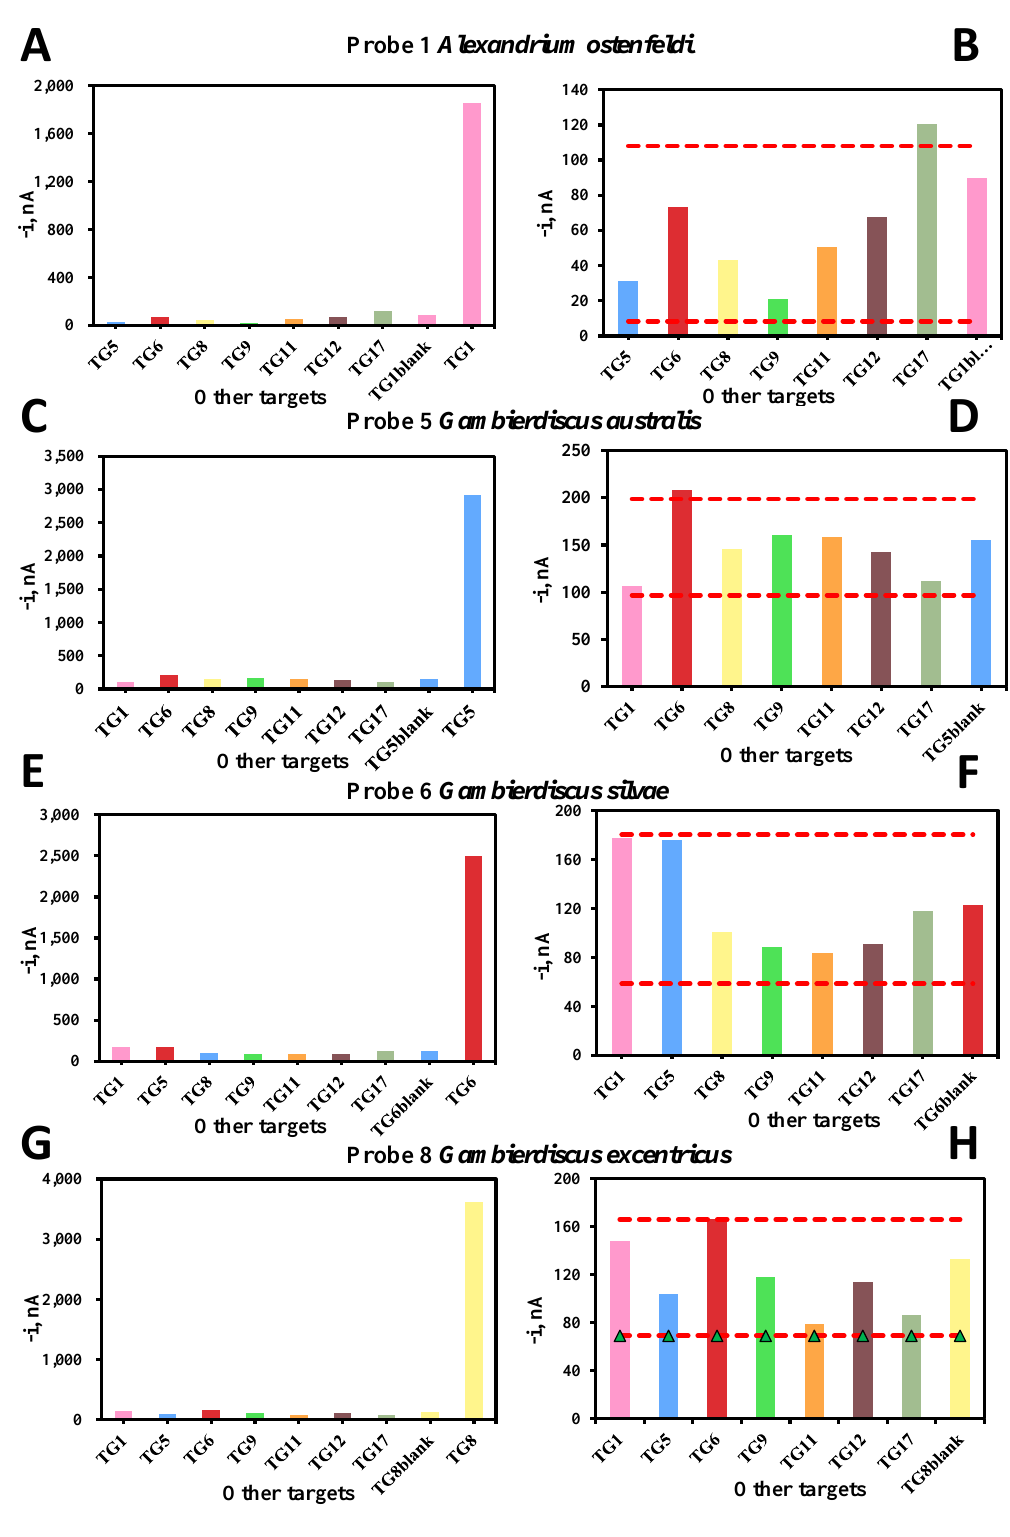
Figure 5. Comparison of cross-reactivity with synthetic targets ( A , C , E , G ) and non-targets ( B , D , F , H ) for Alexandrium and Gambierdiscus probes. +/ − 1 × SD is plotted on the panels to the right to illustrate the signal di ff erence between only non-targets and the blank (no